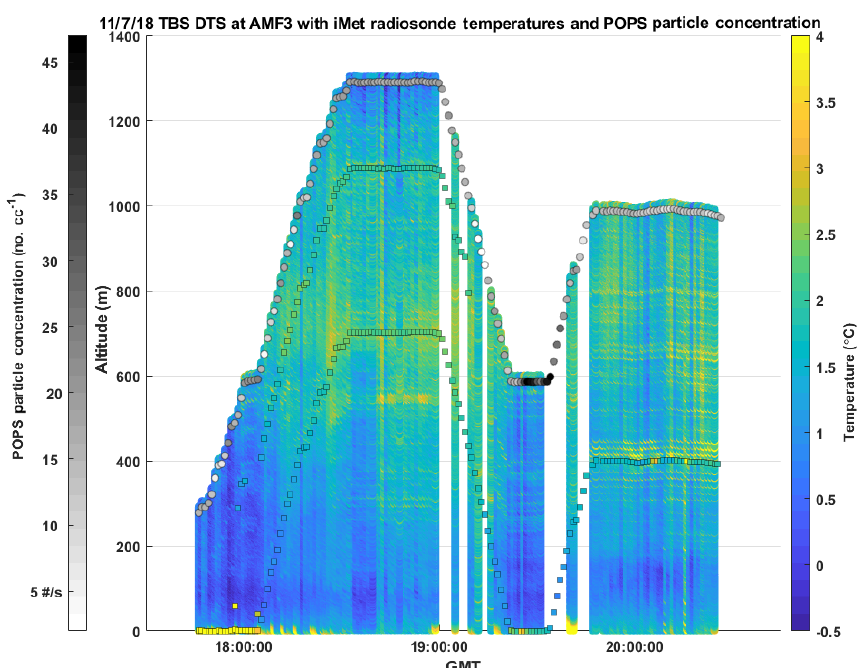
Figure 18. The 11 July 2018 TBS DTS profiles at AMF3 with TBS iMet temperatures (squares) and POPS particle concentrations (circles).